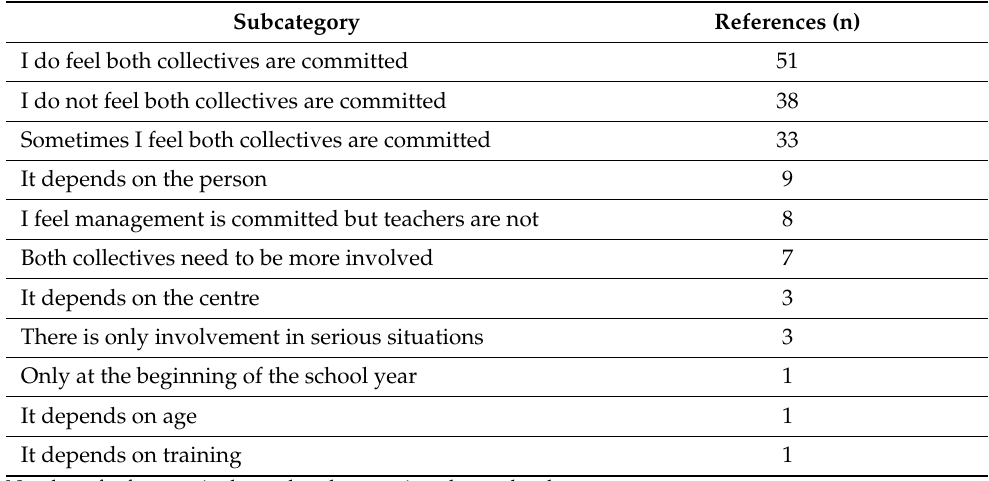
Table 11. Analysis of category 6. Involvement of faculty and the administration in the resolution of conflicts.